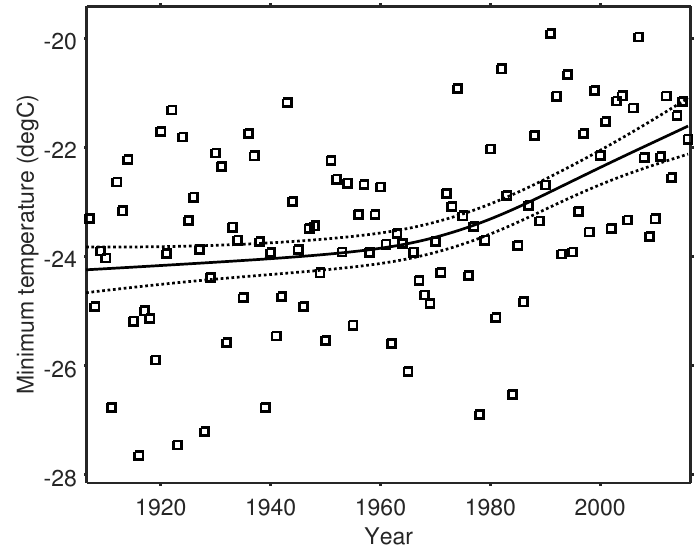
Figure 6. Annual minimum temperature averaged over GHCN-Daily stations for 1970–2016, along with the smoothing spline fit and its 95% confidence